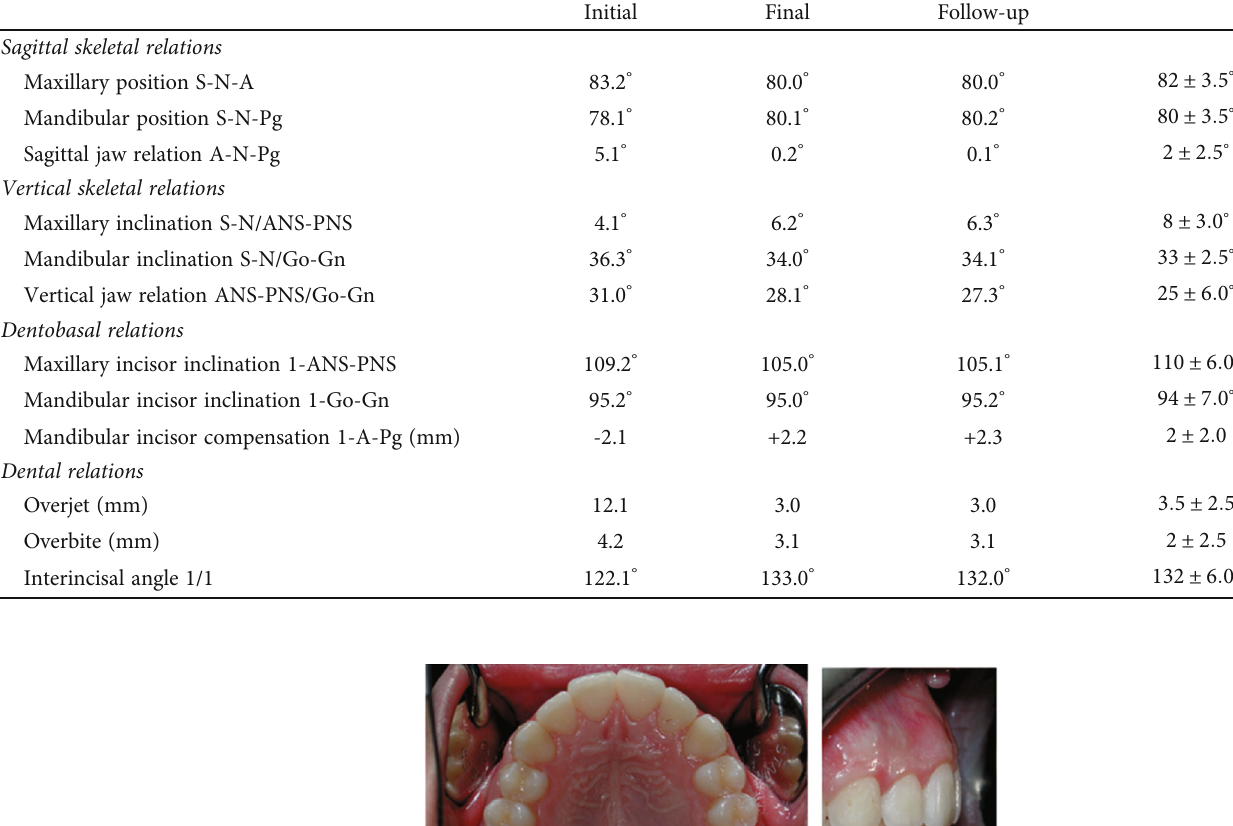
Table 4: Comparison of cephalometric values: before, after, and 2 years posttherapy.